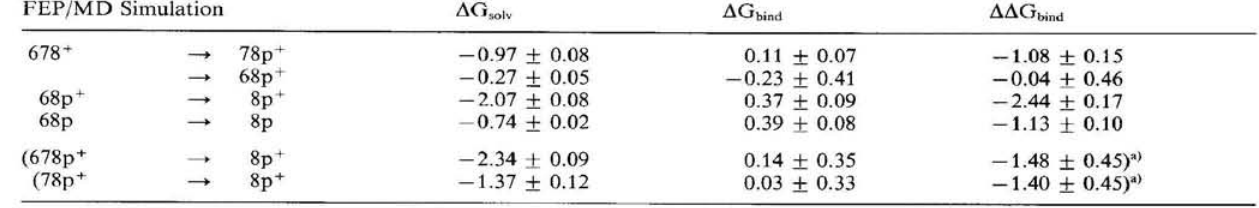
Table 1. Relative free energies (in kcal/mol) for mutations of neutral and cationic forms of some 8-methyl-pterins in aqueous solution (AG S0 | V ), when bound to chicken DHFR(Glu-30").NADPH (AG bind ), and for the total binding process (AAG bind = AG bind — AG so , v ). FEP/MD